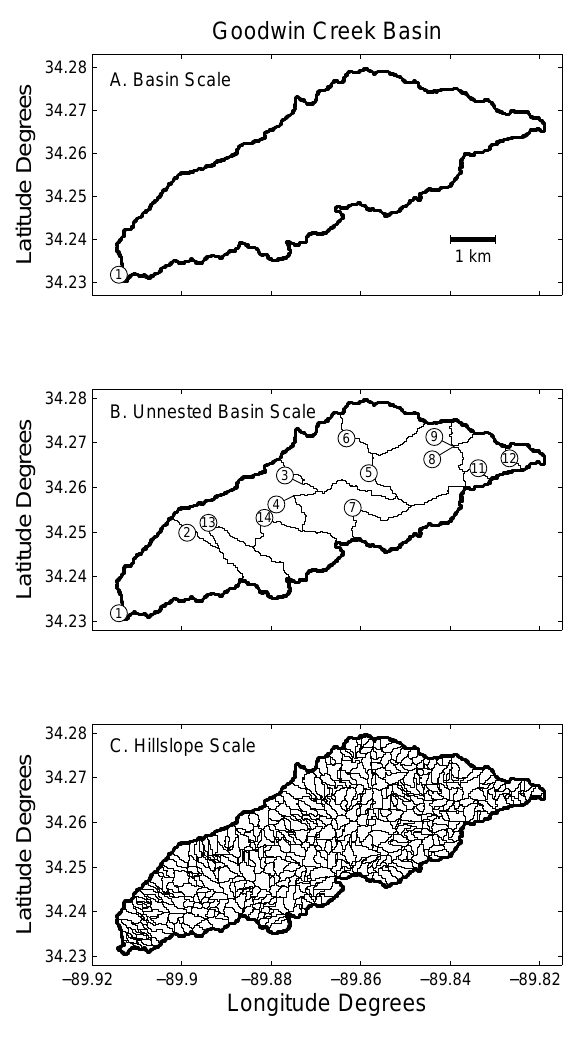
Fig. 1. Decomposition of GCEW into three spatial scales. Plot A shows the basin scale ( a = 21 . 19km 2 ) along with the location of stream gauge 1, the outlet of GCEW. Plot B shows the unnested basin scale ( a/n = 1 . 63km 2 ) and the locations of 13 stream gauges. Plot C shows the hillslope scale ( a/m = 0 . 04km 2 ).